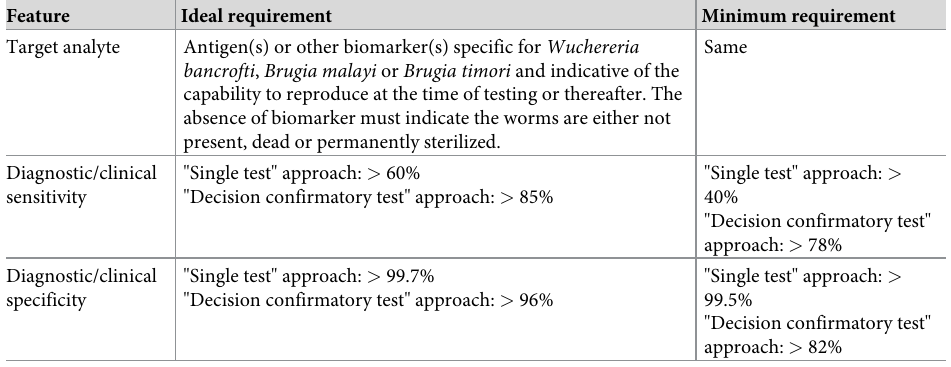
Table 3. Select characteristics of needed test to support stopping IDA decisions.